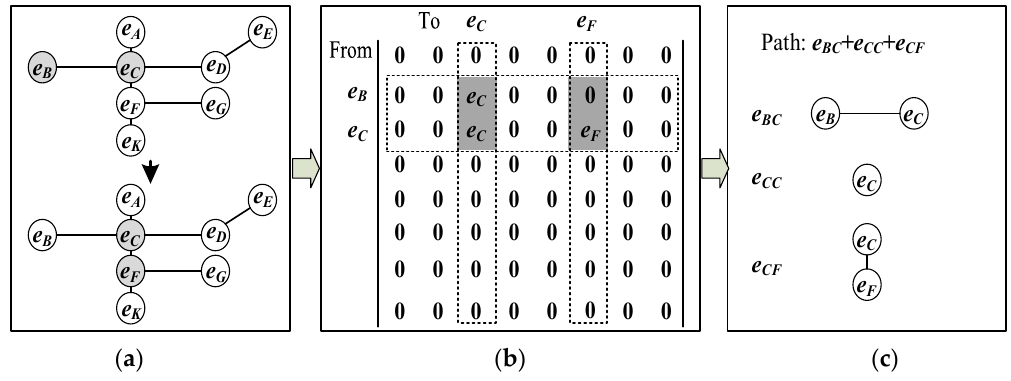
Figure 2. Definition of the activation response network. ( a ) Activated sequences of sensors: